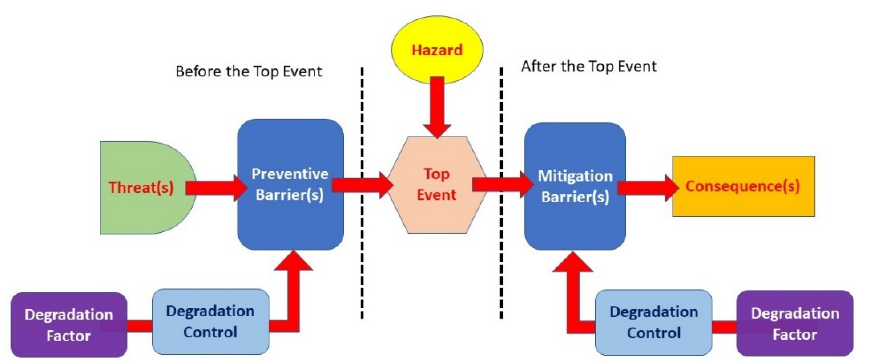
Figure 4. Bow Tie Analysis diagram.